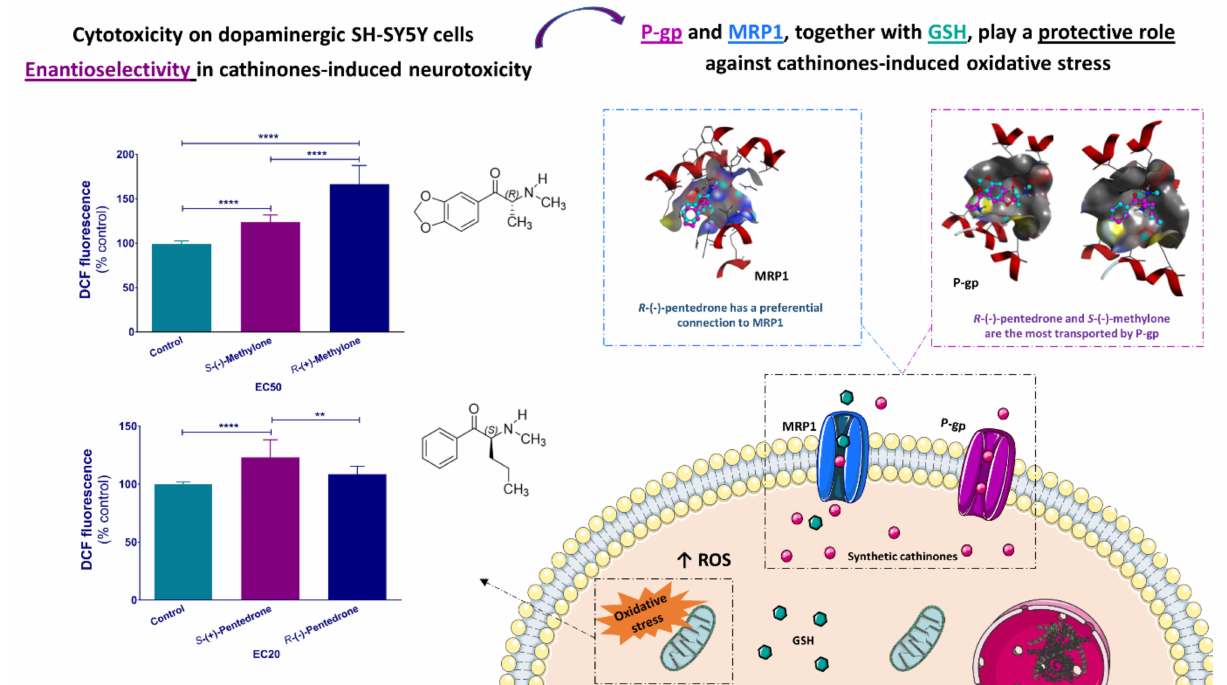
Figure 16. Enantioselectivity studies on neurocytotoxicity of methylone ( 24 ) and pentedrone ( 14 ) towards dopaminergic SH-SY5Y cells and the role of the efflux transporter multidrug-resistance- associated protein 1 (MRP1) and P-glycoprotein (P-gp). ** p < 0.01, **** p < 0.0001. (Reprint